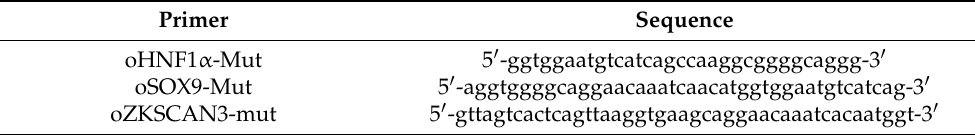
Table 2. Mutagenesis